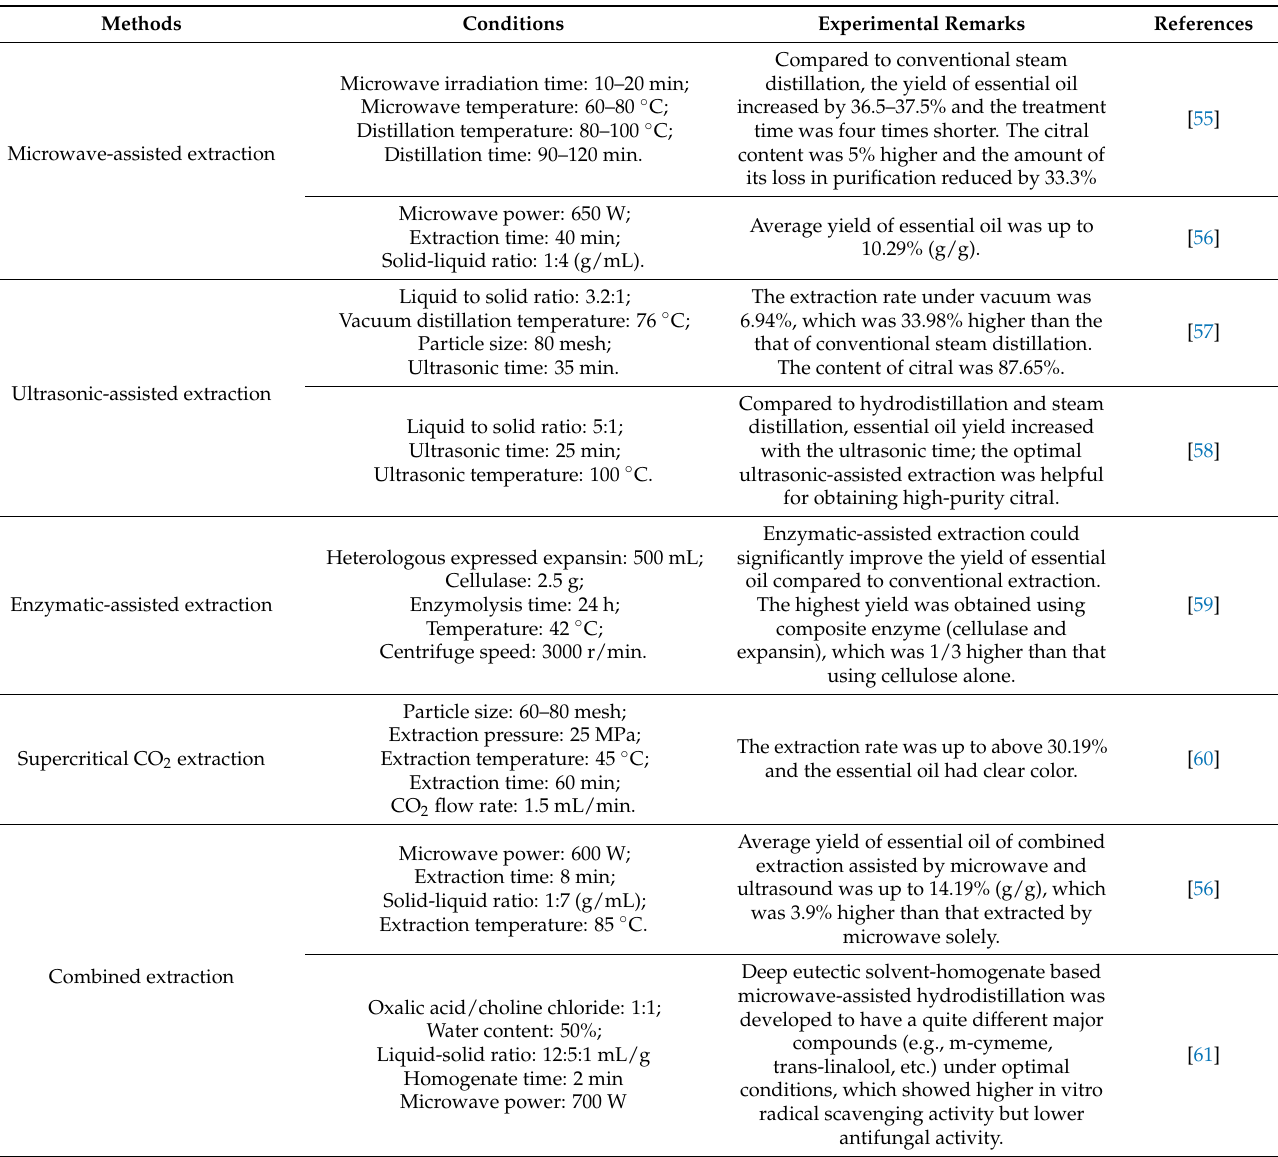
Table 2. Methods for extracting Litsea cubeba essential